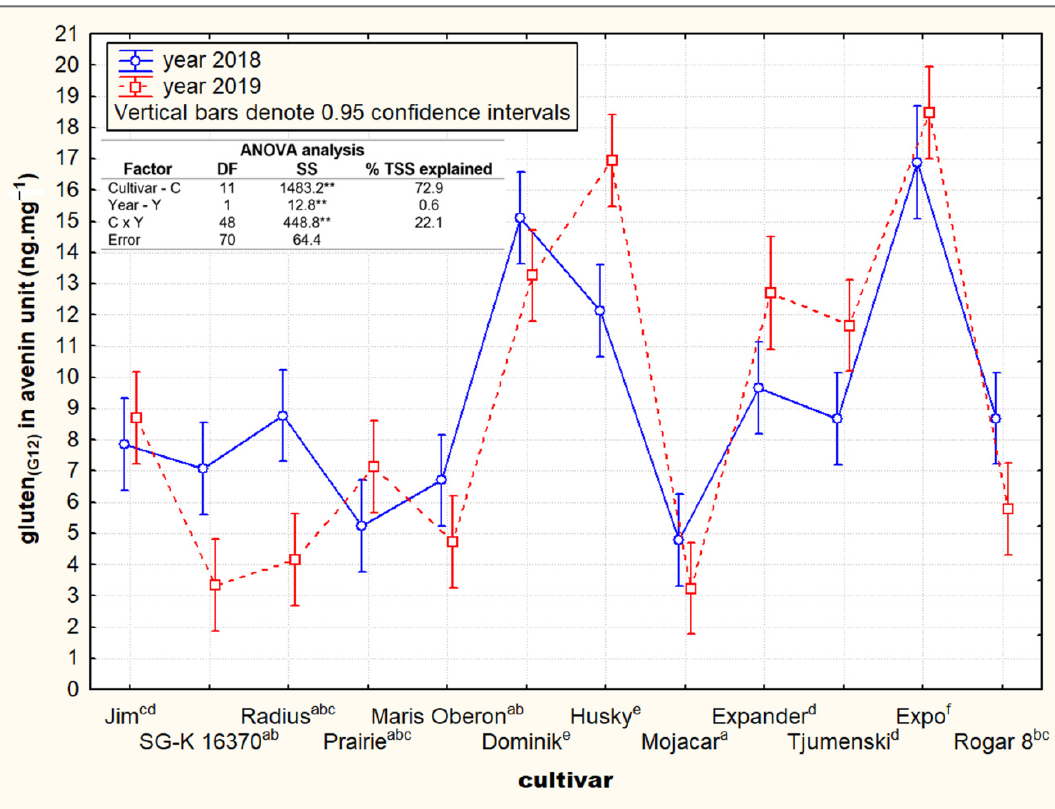
Figure 6. Oat cultivar differences of cross ‐ reactive avenin peptides (gluten (G12) ) calculated on purified avenin units in defined set of oat cultivars with the low inter ‐ year relative standard deviation ( ≤ 30%) and the lowest average gluten (G12) content ( ≤ 5 mg ∙ kg − 1 ) in dry matter of oat grain. ** significant at p ≤ 0.01. Note 1: Values were obtained on basis of 50 ‐ times ‐ concentrated sample isolation compared to the standard kit procedure. Note 2: Cultivars marked with different letter apostrophes are statistically significant at p ≤